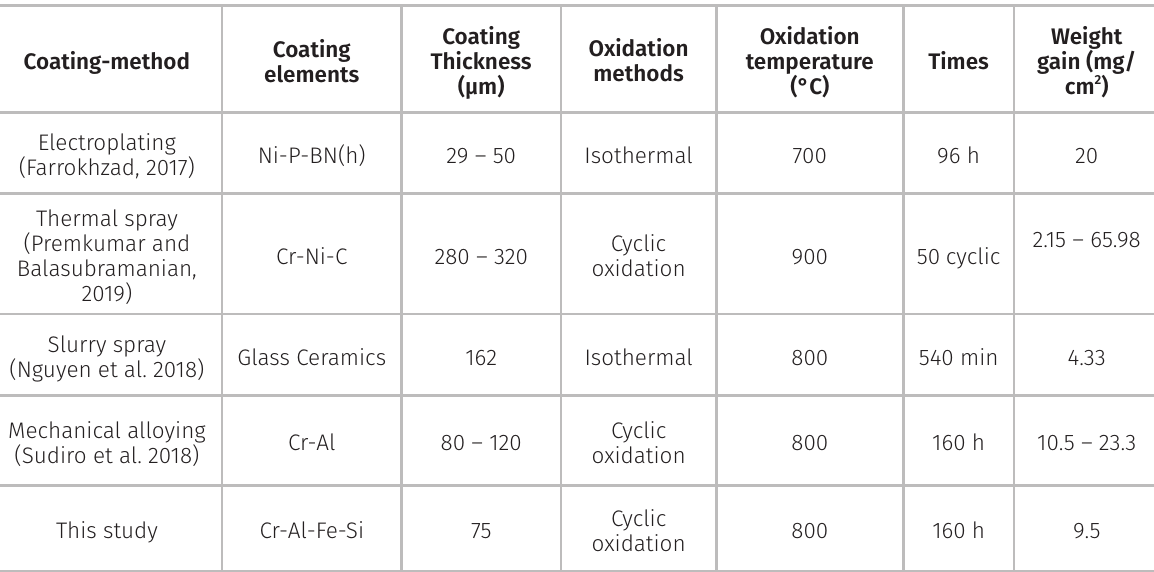
Table VI. Previous research results on the weight gain of the substrate after